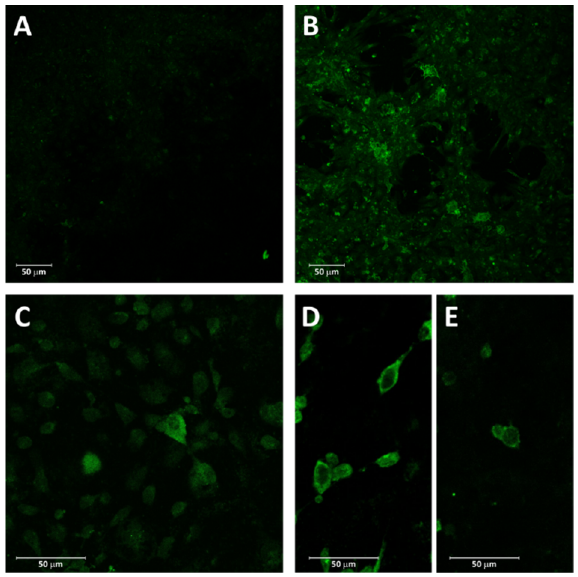
Figure 1. Plasmid transfection assay on EPC cells. ( A ) Negative control. ( B ) VHSV immunofluores- cence signal at 5 days post-inoculation of EPC cells with VHS plasmid, 10×. ( C ) IHNV immunoflu- orescence signal at 7 days post-inoculation of EPC cells with IHN plasmid, 20×. ( D , E ) VHSV and IHNV signal at 5 days post-inoculation of EPC cells with VHS and IHN plasmids, 20×.